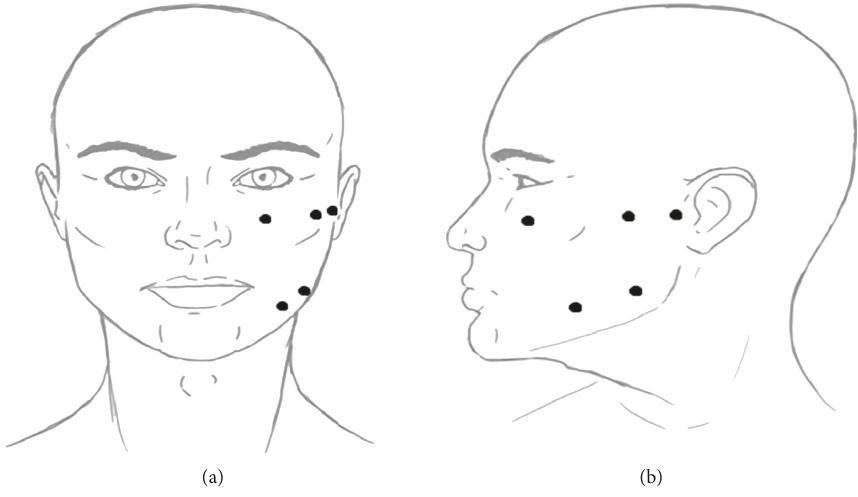
Figure 3: Dry needling points of insertion. Source: own.